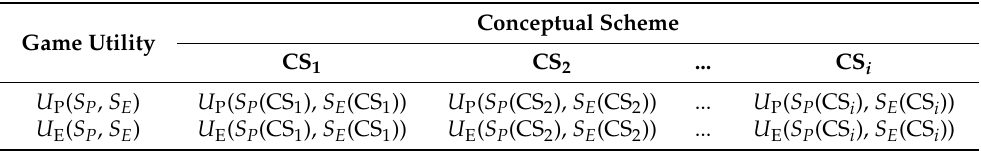
Table 4. Game utility matrix of scheme under each strategy